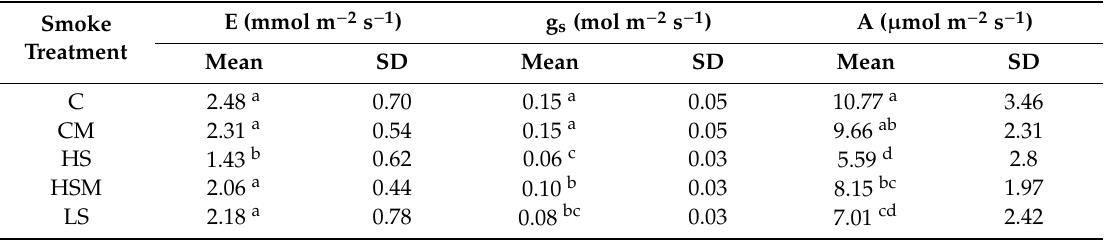
Table 2. Gas exchange parameters measured for the di ff erent smoke